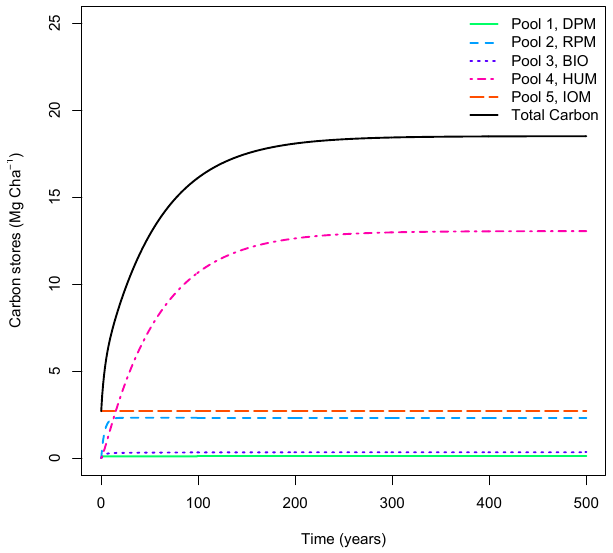
Fig. 4. Carbon accumulation for the different pools included in the RothC model. DPM: the decomposable plant material pool, RPM: resistant plant material, BIO: microbial biomass pool, HUM: humi- fied organic matterpool, and IOM: inert organic matter pool.